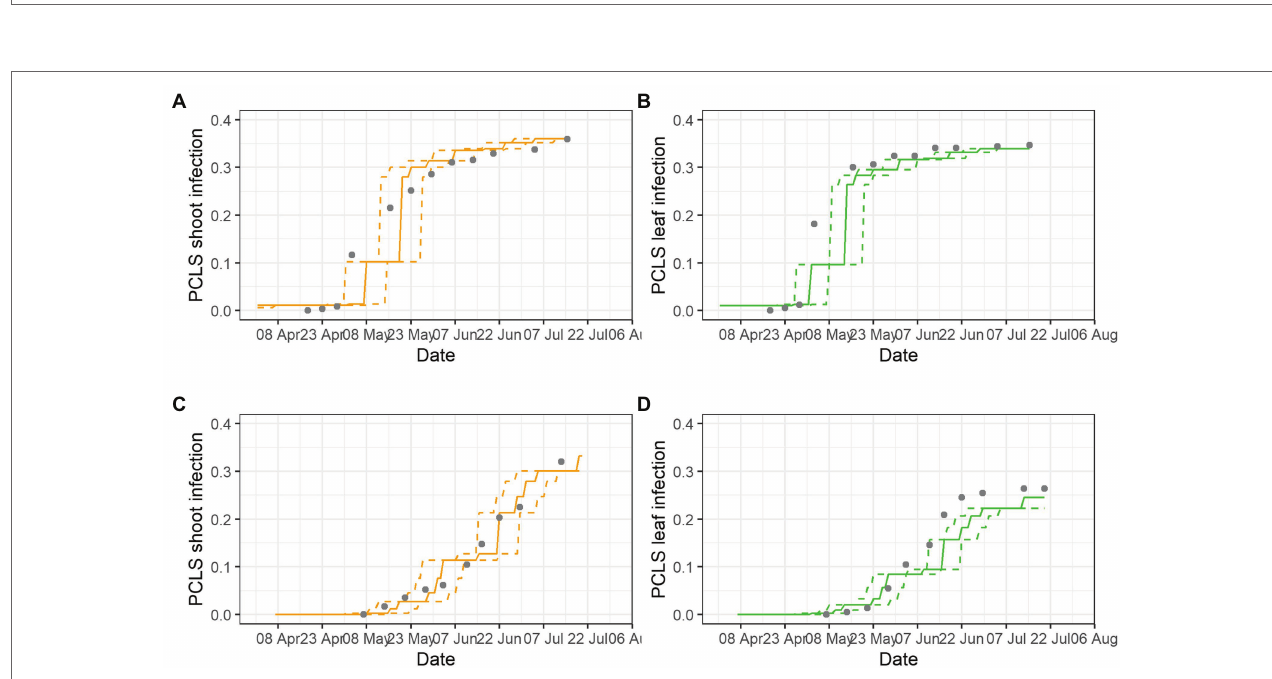
FIGURE 5 | Comparison of model output and PCLS incidence observed on shoots (A,C) and leaves (B,D) in epidemics BP-2020 (A,B) and PI-2020 (C,D) . Dots represent the observed PCLS incidence; lines represent the predicted disease progress on leaves (unbroken green lines) or shoots (unbroken orange lines), and their prediction interval based on the variability of the incubation length (dotted lines).